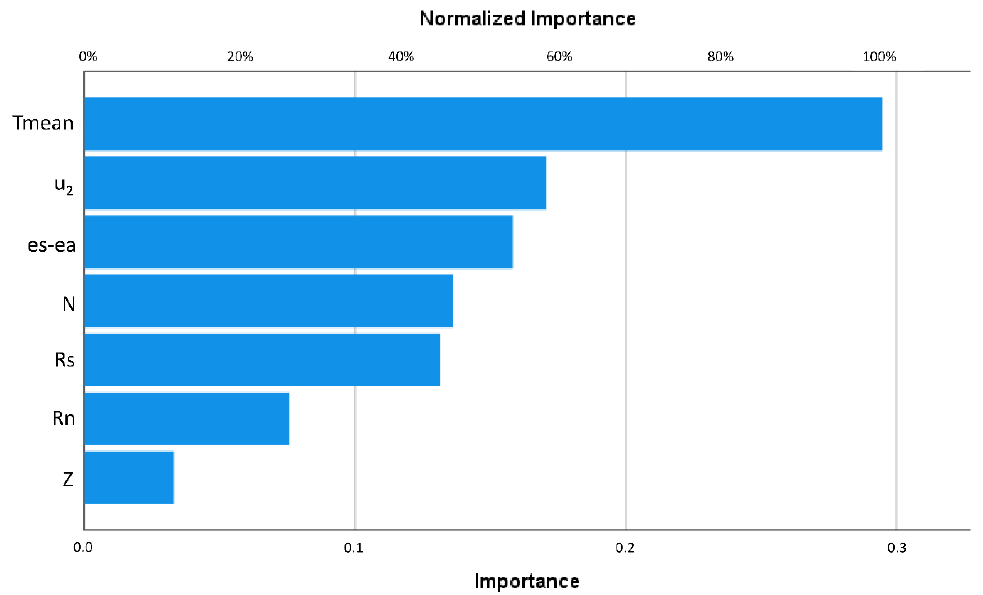
Figure 3. Normalized importance of the input variables of the model with the best performance (MLP1) in ETo prediction of the Peloponnese.